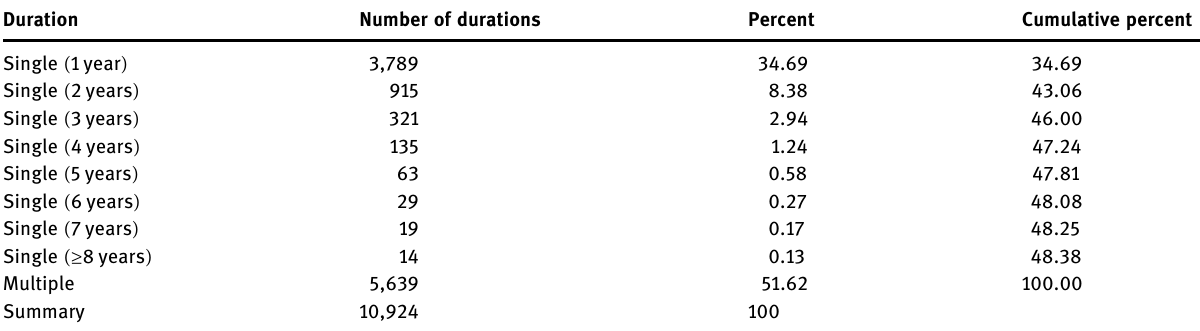
Summary 10,924 100 Data source: Chinese industrial fi rm database.